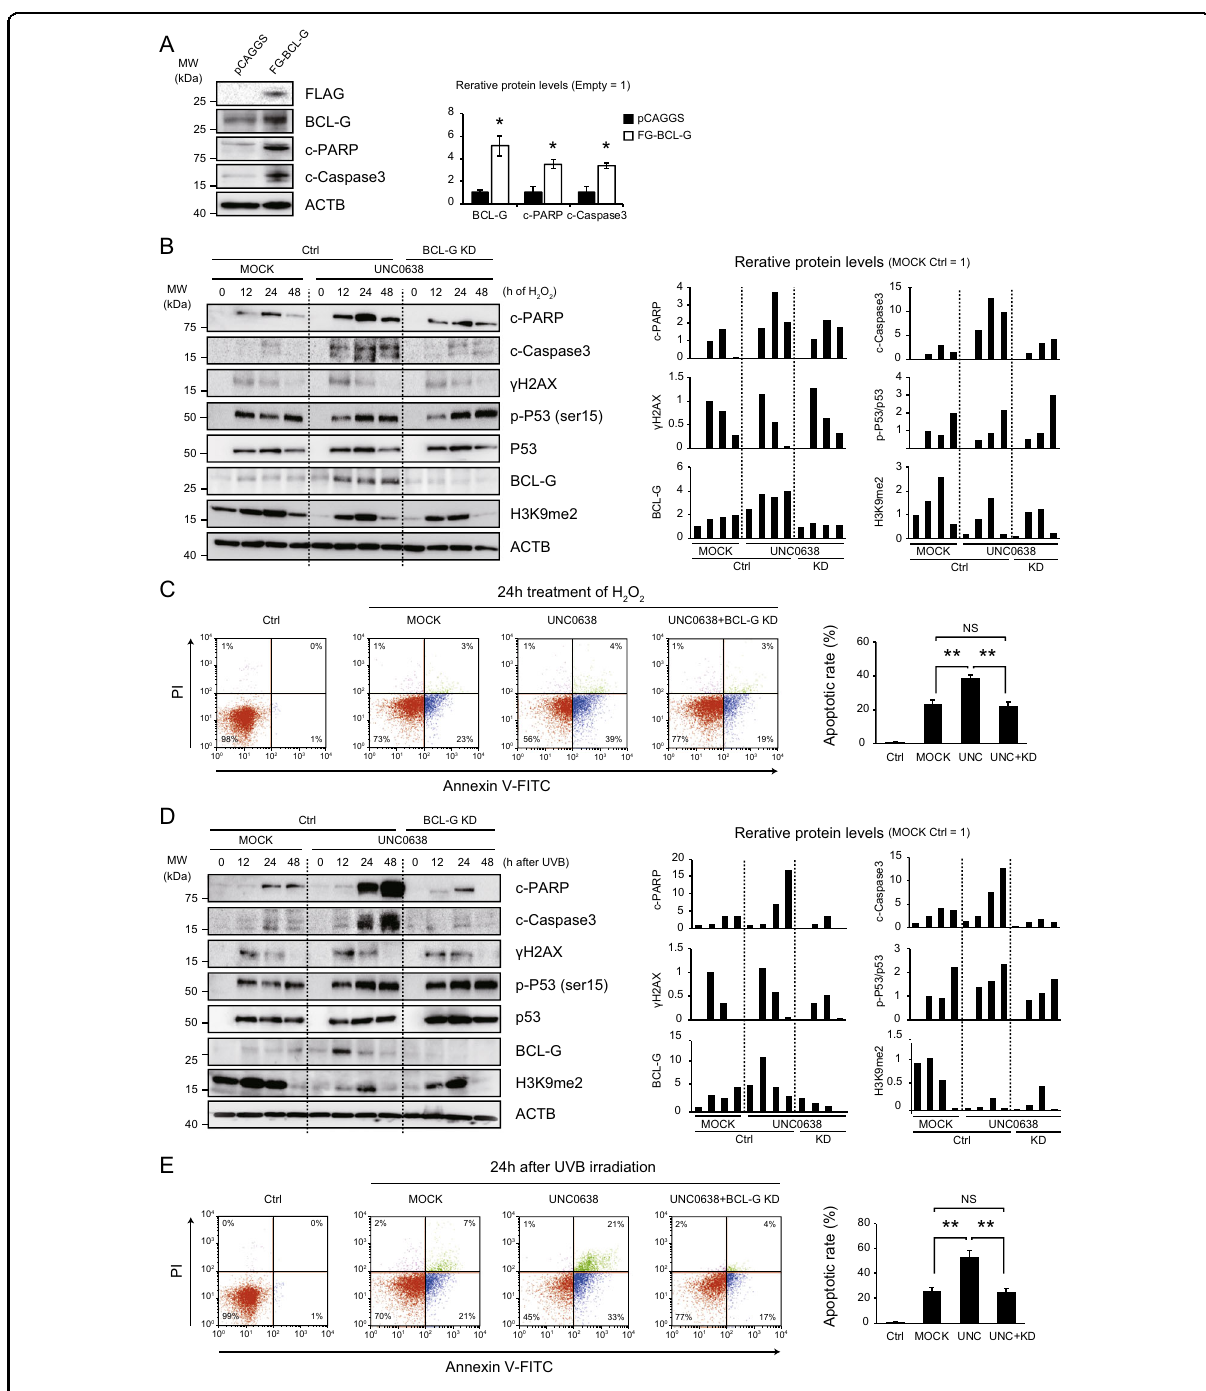
Fig. 4 BCL-G is involved in apoptosis during the DNA damage response in hepatocytes. A BCL-G overexpression induces apoptotic changes in normal human hepatocytes. Representative immunoblot images and relative expression levels of the proteins are shown (each, n = 3; * p < 0.05, Student ’ s t test). B , D The G9a inhibitor UNC0638 (5 µM) promotes apoptosis in hepatocytes after treatment with hydrogen peroxide (H 2 O 2 , 2 mM) or UVB irradiation (300 J/m 2 ) with an increase in BCL-G expression. Bcl-G knockdown (KD) suppresses the excessive induction of apoptosis caused by a G9a inhibitor. Right graphs show quanti fi cation of relative protein levels. C , E Representative dot-plot diagrams showing the percentage of the hepatocyte lines stained with Annexin V-FITC and propidium iodide (PI) after 24 h of treatment with H 2 O 2 or UVB irradiation. The results of three independent experiments are shown in the right graph (** p < 0.01, NS not signi fi cant, Student ’ s t